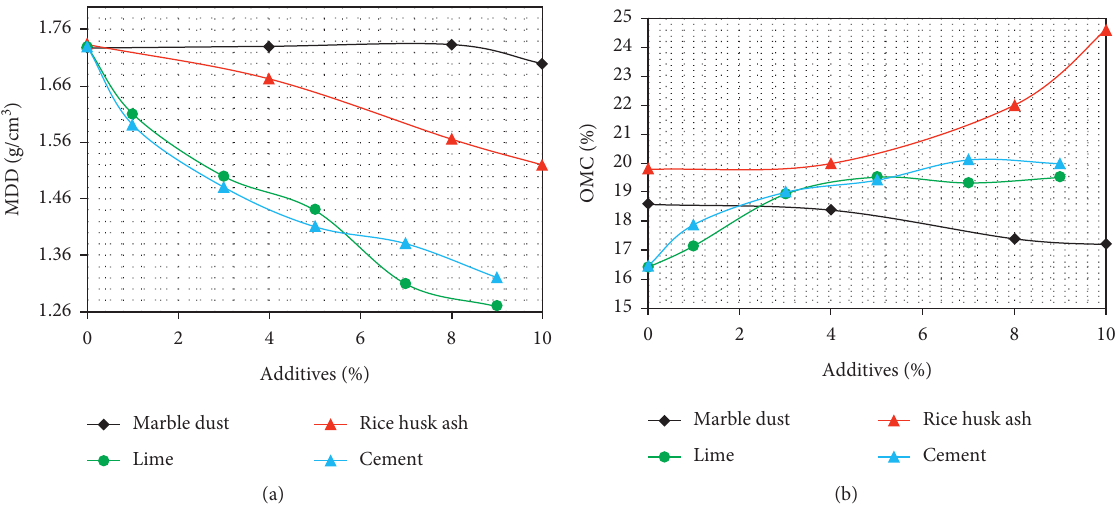
Figure 6: (a, b) Compaction characteristics with marble dust/rice husk ash. Note: Data of lime and cement in “a” and “b” is taken from Sharma et al. [18] for purpose of